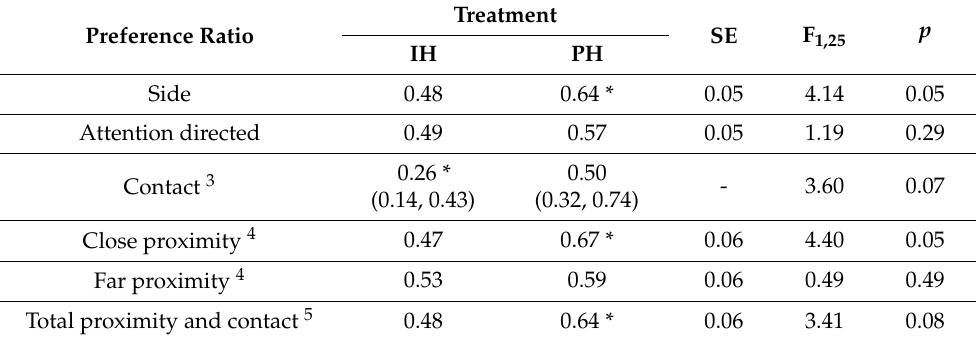
Table 3. Effects of housing treatment, with calves housed individually (IH) or in pairs (PH), on dairy calf 1 social preference ratios 2 during a social preference test conducted at 4 weeks of life (29.3 ± 1.9 d of age).